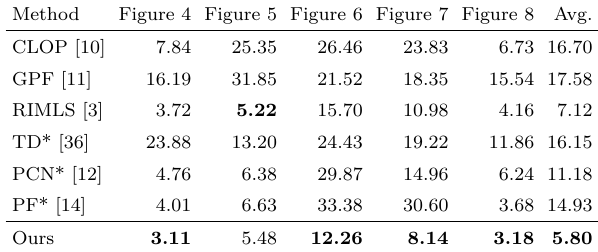
Table 2 Quantitative evaluation of methods on the synthetic point clouds in Figs. 4–8. Deep learning methods are indicated by *. Metric used is Chamfer Distance ( × 10 − 5 ), The best method for each model is highlighted in bold